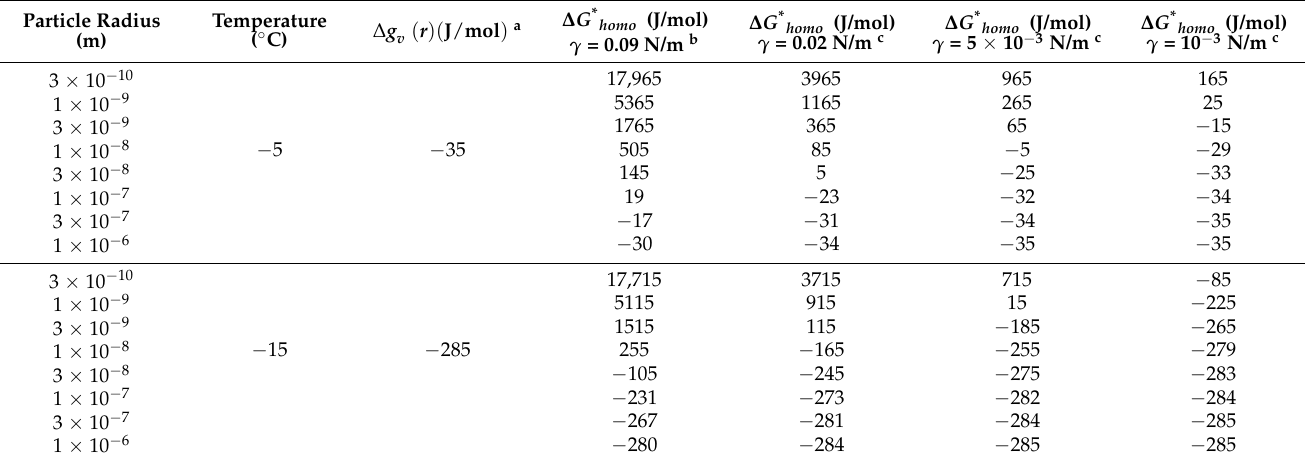
Table 1. Gibbs energy for the formation of small ice particles from vapor, at two temperatures below zero Celsius and considering four different values for the ice-air interfacial